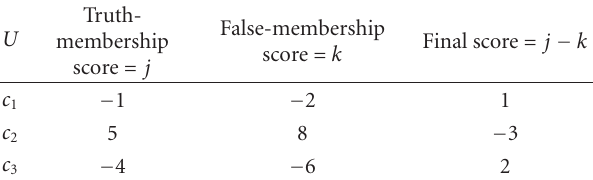
Table 11: Final score